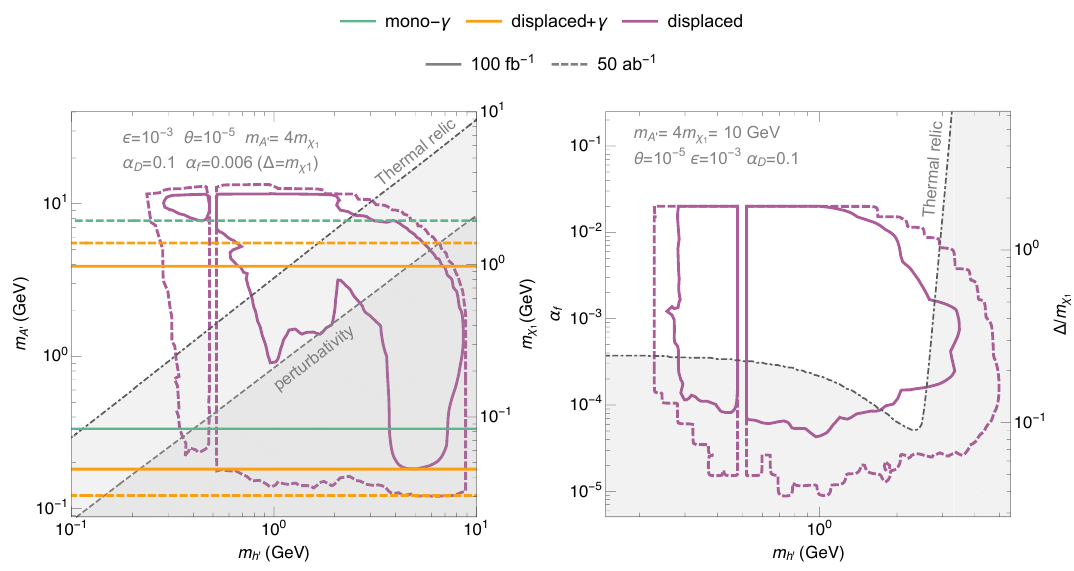
Figure 5 . Expected sensitivities of the different searches at Belle II in the (left) m h 0 − m A 0 plane and in the (right) m plane for integrated luminosities of 100 fb − 1 (solid lines) and 50 ab − 1 h 0 − α f (dashed